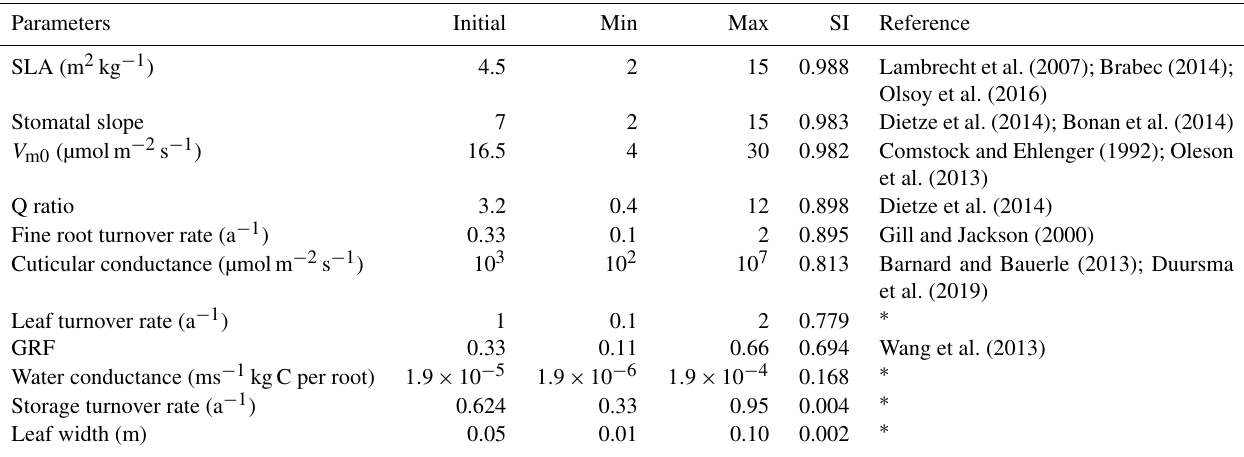
Table 4. Summary of sensitivity analysis of studied PFT parameters ranked by sensitivity index (SI). Parameters